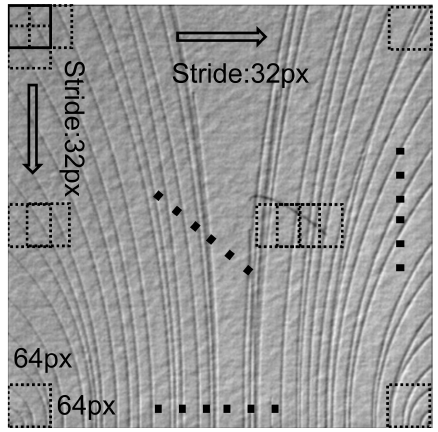
Figure 8. The sliding-window method in DAGM 2007. Extract all 64 × 64 patches in the image in 32 strides for